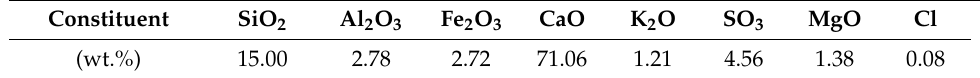
Table 2. Chemical composition of the OPC.